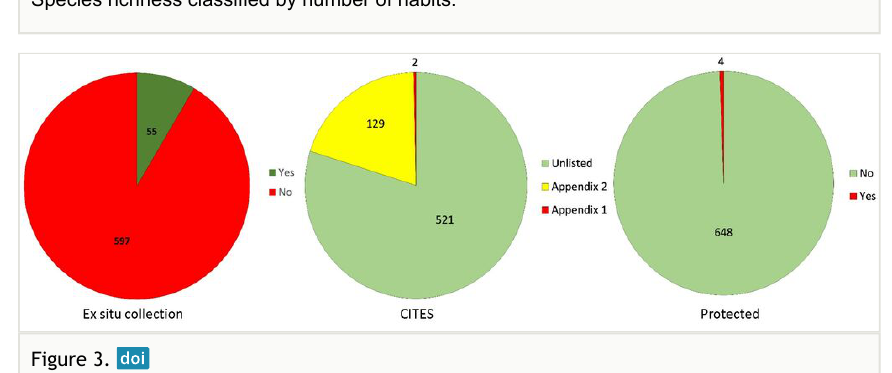
Species richness classified by number of habits.